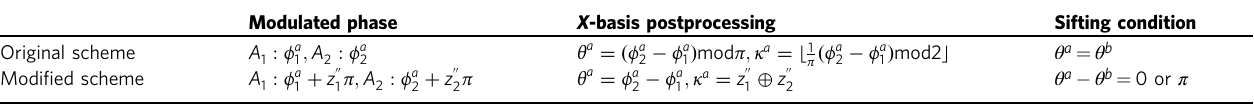
Table 1 Comparison of the phase encoding and postprocessing procedures of the mode-pairing scheme presented in the main text and the modi fi ed scheme considered in the security